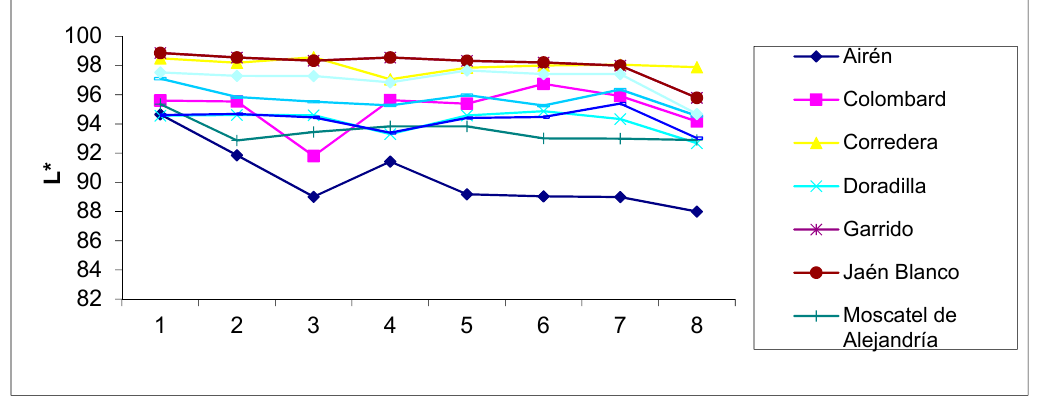
Figure 2. Evolution of the L* (brightness of color) values in the aged distillates of the di ff erent varieties.